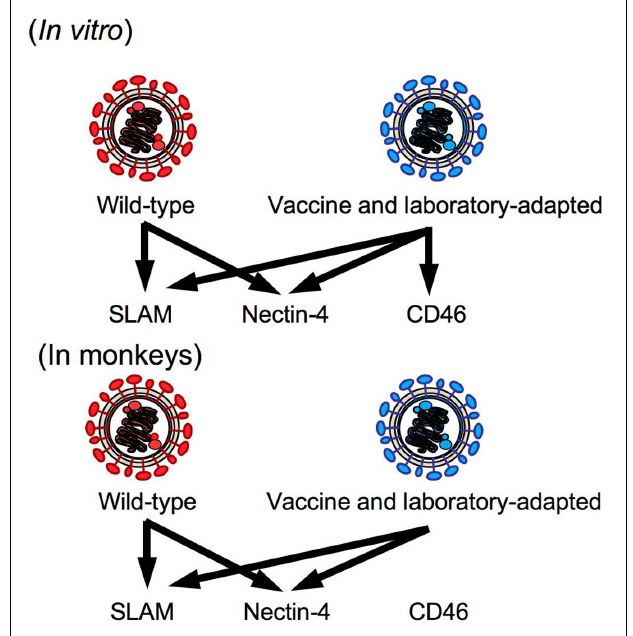
FIGURE 3 | Receptor usage of the wild-type and vaccine and laboratory-adapted strains of MV. Nectin-4 is a recently identified epithelial cell receptor for